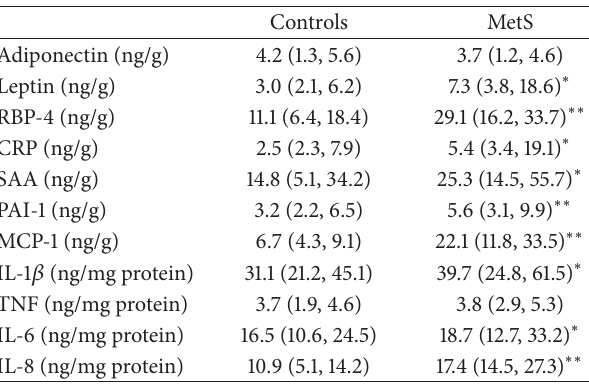
Table 1: Subcutaneous adipose tissue biomarker levels.